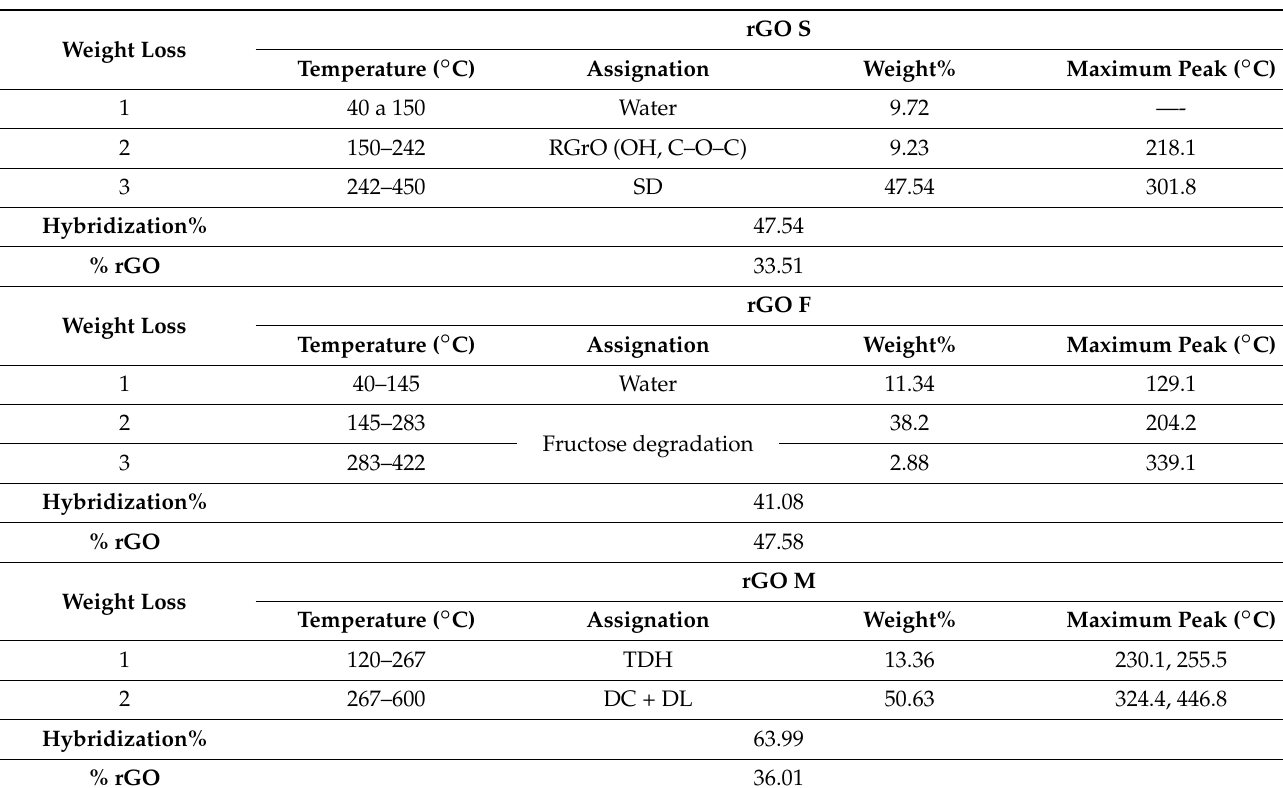
Table 2. Weight loss determined by TGA of rGO S, rGO F, and rGO M nanohybrids.